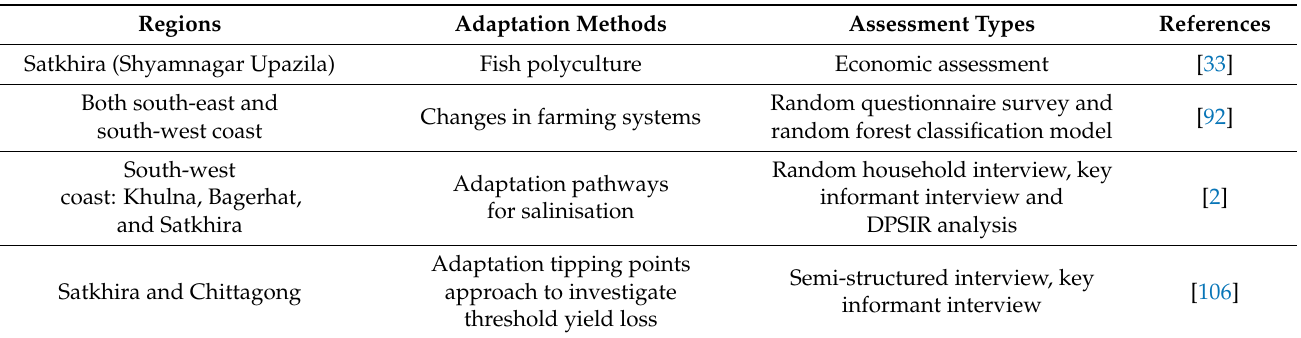
Table 3. Adaptation techniques in the changing saline